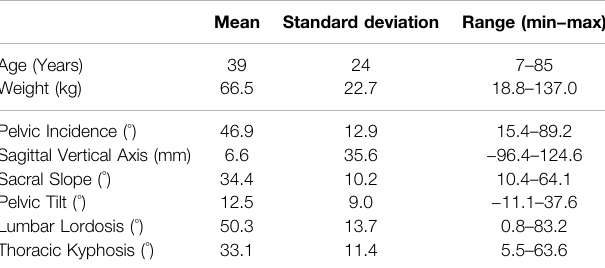
TABLE 2 | Mean, standard deviation, and range (minimum-maximum) are speci fi edfor age,weight,and spinopelvic parameters ofthesubjectsincluded in this study. Except for age, all the information were computed based on annotated EOS